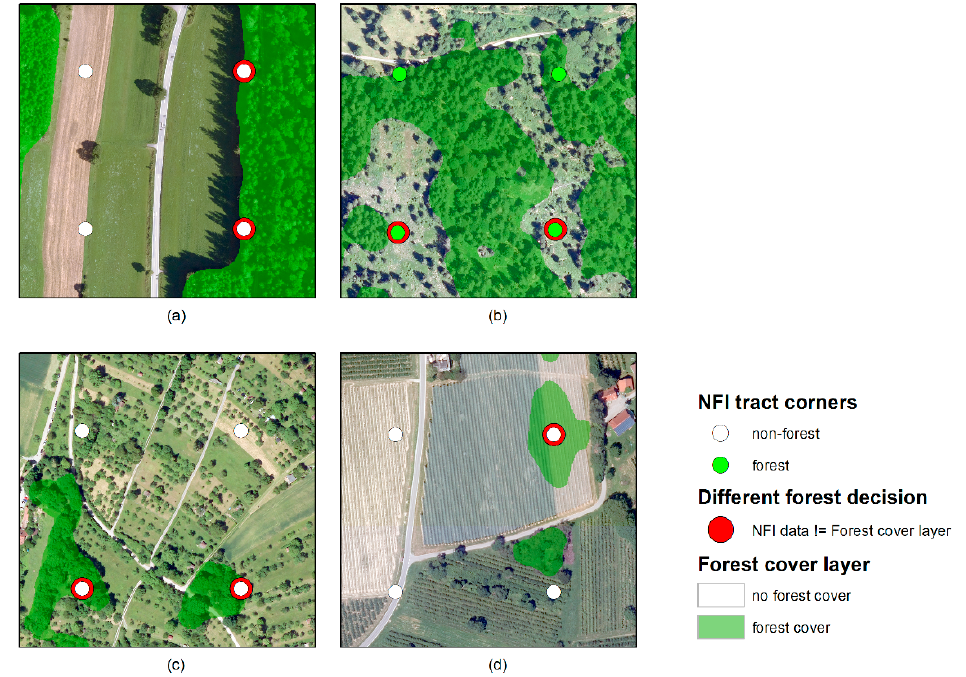
Figure 7. Categories of reasons for different forest decisions in the NFI plot data and forest cover map: ( a ) edge effects, ( b ) different forest definition (NFI does not define minimum height of trees), ( c ) land use not equal to land cover, ( d ) errors in forest cover layer. Differences are outlined in red. Based on the defined categories, each incongruent NFI plot was assigned to a specific category.